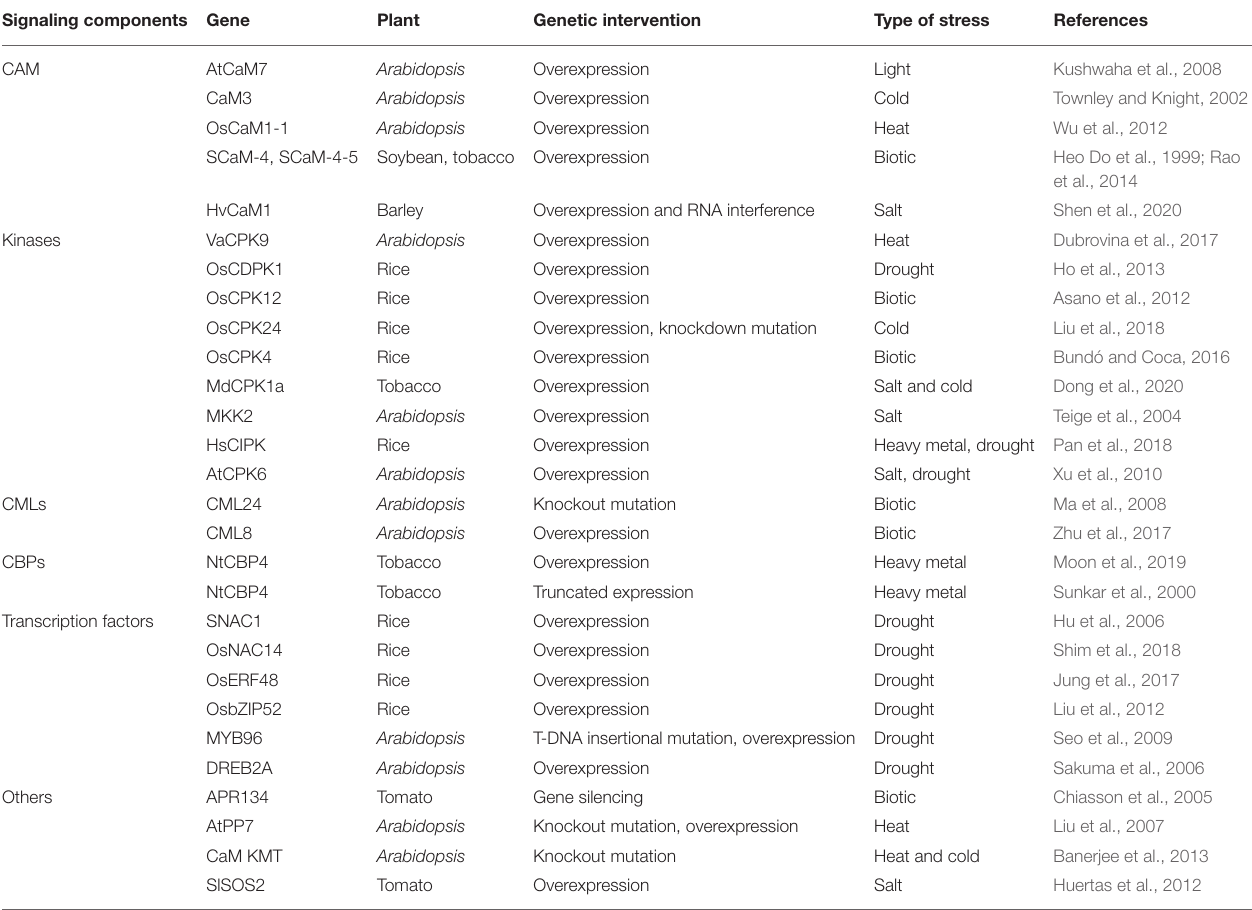
TABLE 1 | Functional genomics studies on Ca 2 + /CaM-signaling components for conferring stress tolerance in plants. Signaling components